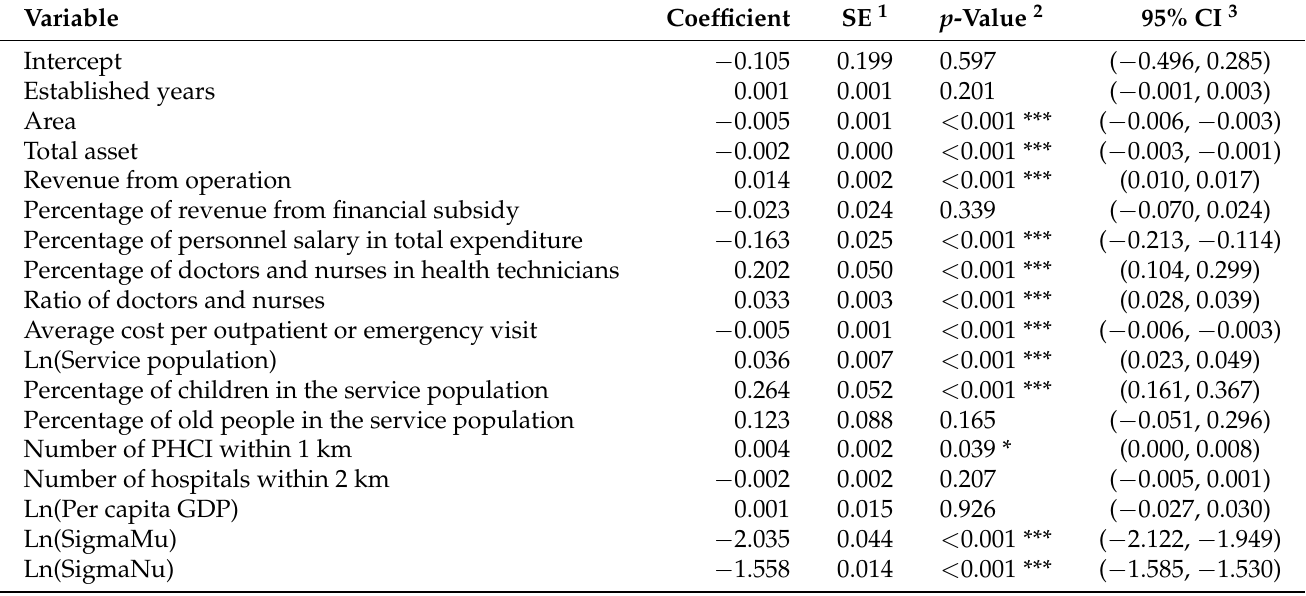
Table 7. Result of Tobit regression (N =